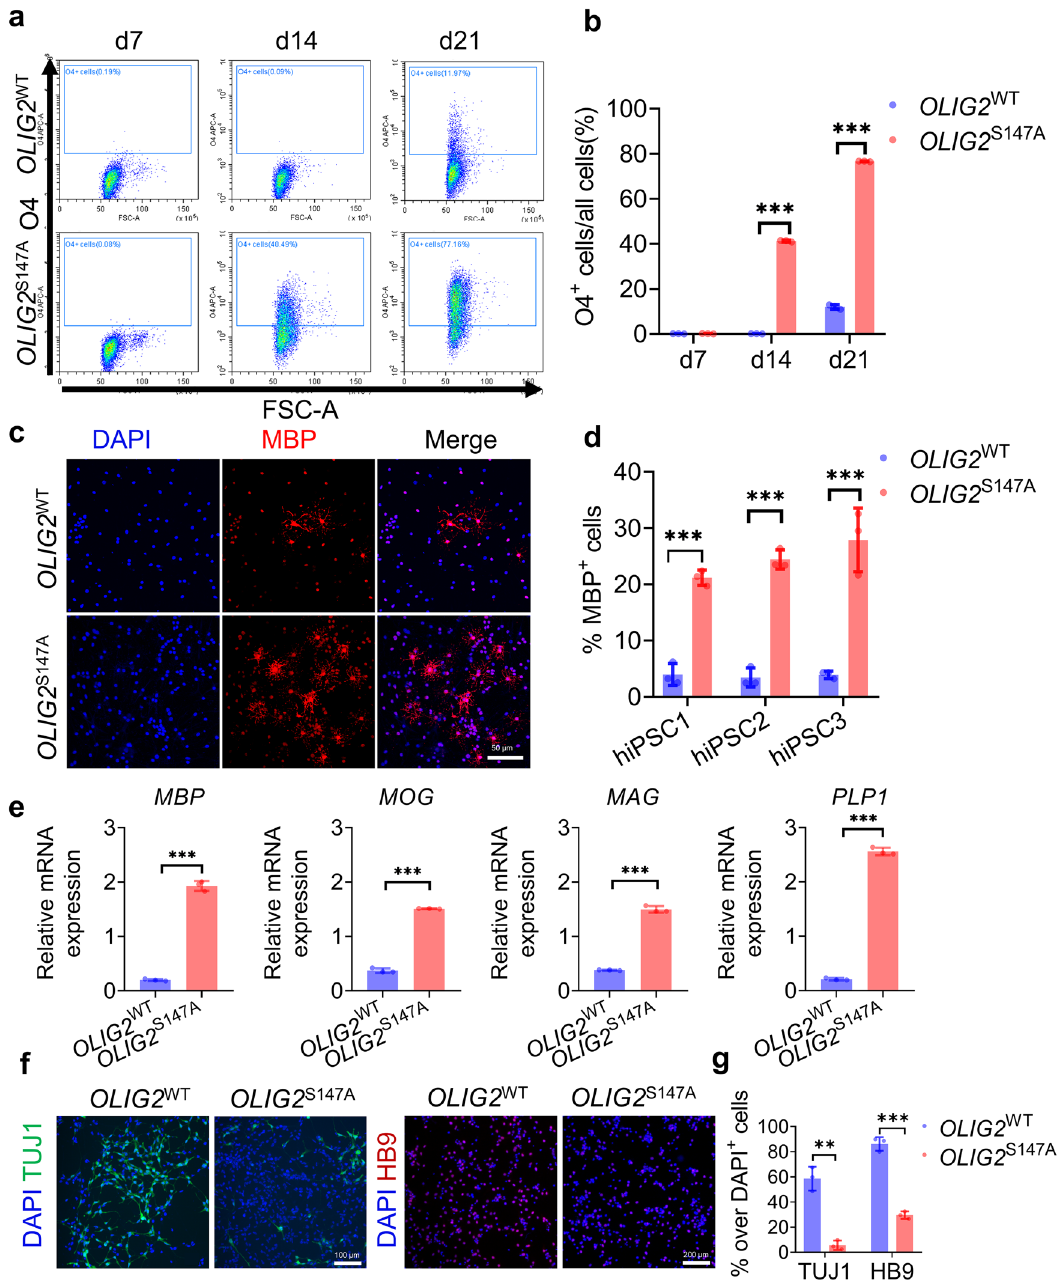
Fig. 3 Maturation of OLIG2 smRNA-treated OPCs into myelinating OLs. a Representative fl ow cytometry analyses of the expression of O4 in the OLIG2 WT and OLIG2 S147A smRNA-transfected cells at 7, 14 and 21 days after transfection. b Quanti fi cation of O4 + cells among OLIG2 WT and OLIG2 S147A smRNA-transfected cells at 7, 14 and 21 days after transfection ( n = 3, *** p < 0.001 using two-tailed Student ’ s t test). c Representative images of immunostaining for MBP in cultured cells of the three different hiPSC lines on day 21 after smRNA transfection (scale bar, 50 μ m). d Quanti fi cation of the number of MBP-positive cells among cells of the hiPSC1 line on day 21 after smRNA transfection ( n = 3; *** p < 0.001 using two-tailed Student ’ s t test). e mRNA expression levels on day 21 of the OL differentiation protocol ( n = 3, *** p < 0.001 using two-tailed Student ’ s t test). f Representative images of immunostaining for TUJ1 and HB9 in hiPSC1-derived cells on day 21 after smRNA transfection (scale bar, 100 μ m (left) and 200 μ m (right)). g Quanti fi cation of TUJ1- and HB9-positive cells among hiPSC1-derived cells ( n = 3, ** p < 0.01, *** p < 0.001 using two-tailed Student ’ s t